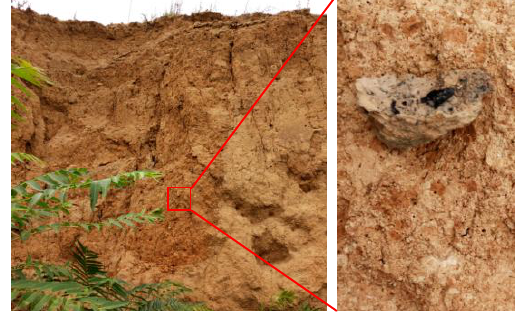
Figure 1. Difference of soil component and colour